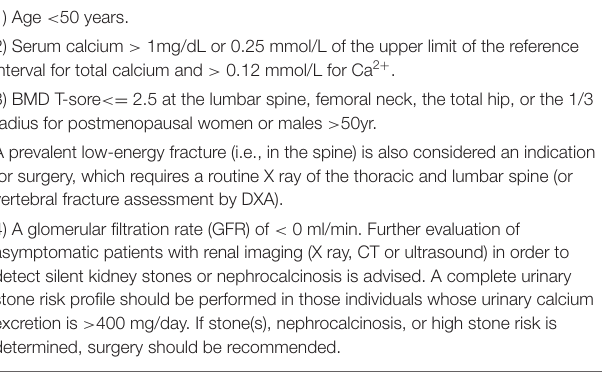
TABLE 2 | Indication for surgery in the treatment of primary hyperthyroidism.